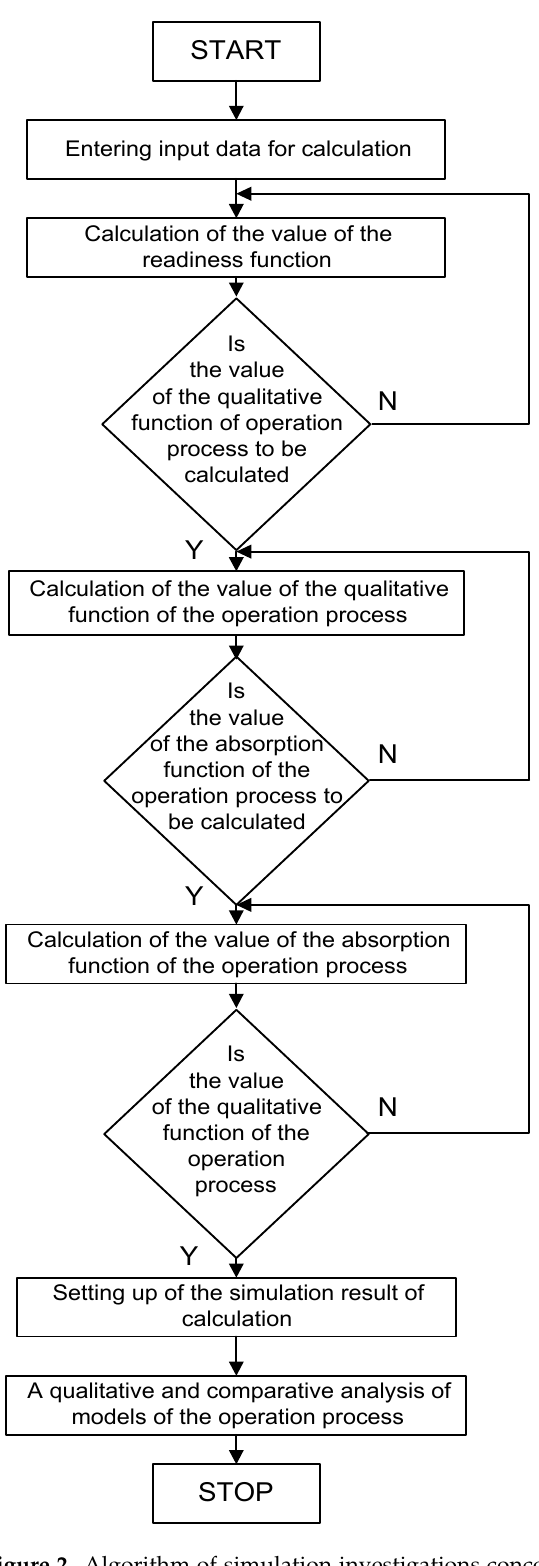
Figure 2. Algorithm of simulation investigations concerning the quality of the assessment of the operation process of the technical object.